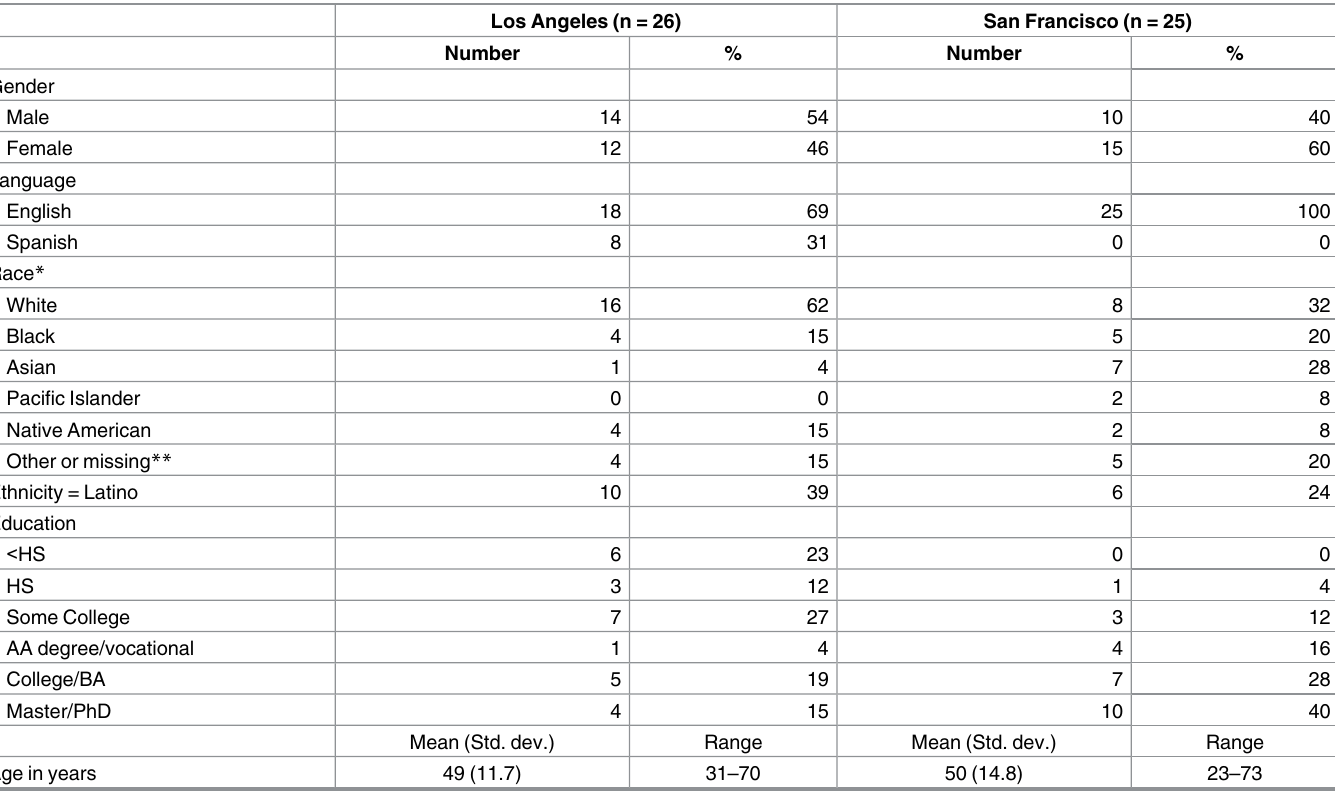
Table 1. Participant Demographics Table.